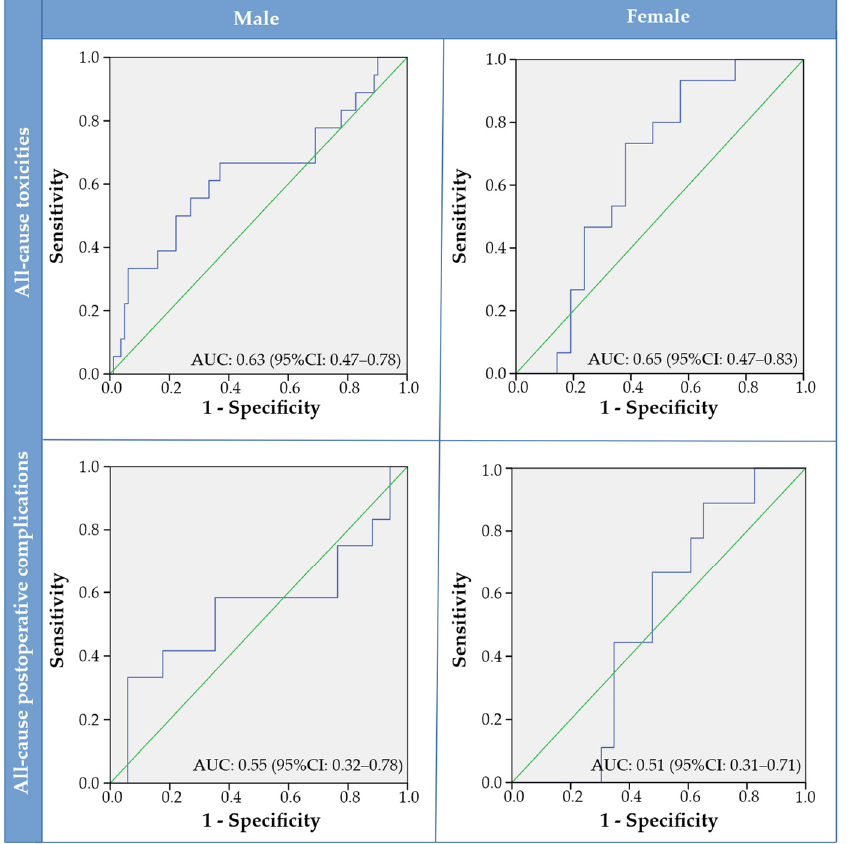
Figure 2. Receiver operator characteristic curves stratified for males versus females and all-cause toxicities versus all-cause postoperative complications. Abbreviations: AUC = area under the curve, CI = confidence interval .